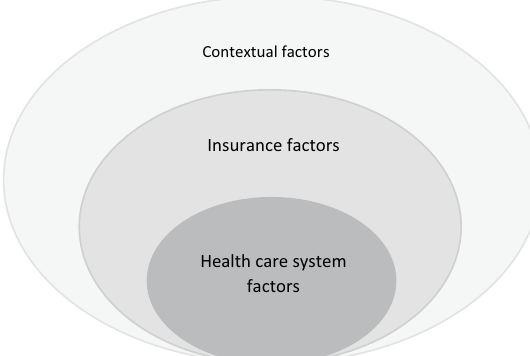
Fig. 1 Barriers to health care provision and utilization among those with T2D living in